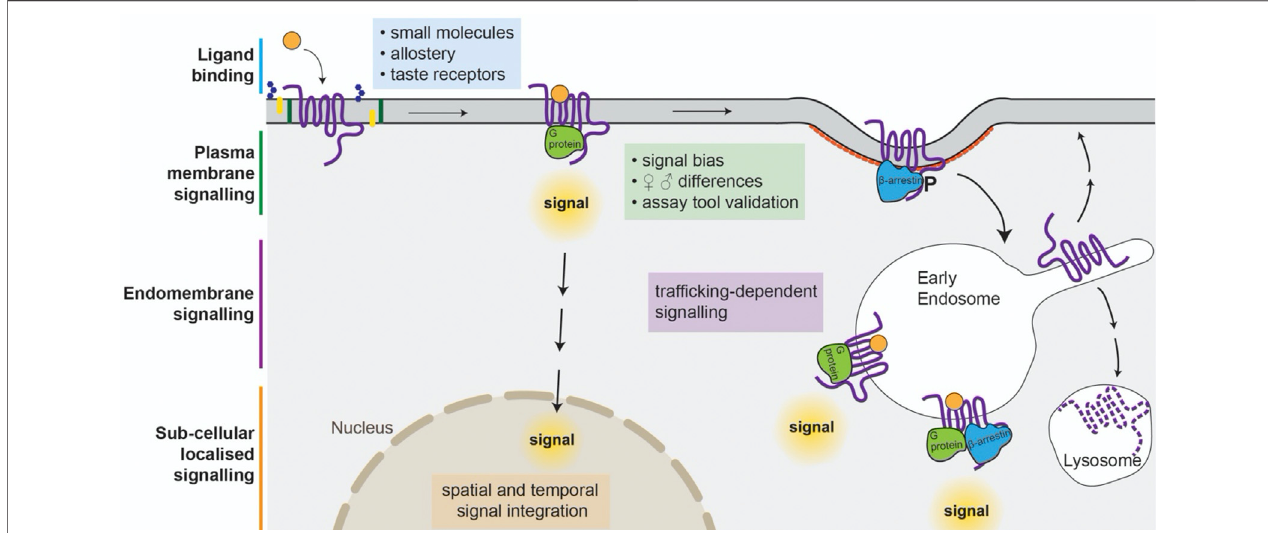
FIGURE 1 | Factors affecting signalling in response to activation of GPCRs. Glycolipids (blue hexagons), phospholipids (green rectangles), and sterols (yellow) can in fl uence ligand binding at orthosteric, and allosteric sites. Ligands can produce different receptor conformations leading to different signalling patterns and degrees of interaction with β -arrestins, internalisation, and desensitisation. Ligands with differing physicochemical properties can result in altered spatial and temporal signal integration, and affect the relative degree of cell surface/intracellular signal transduction as well as in fl uencing receptor recycling or lysosomal degradation.